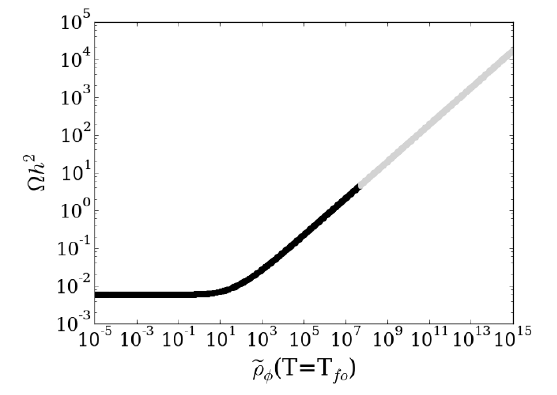
Figure 10. The increase in the relic density for Point B as a function of the ratio of the scalar density and the radiation density at 1 MeV. The grey region is excluded by